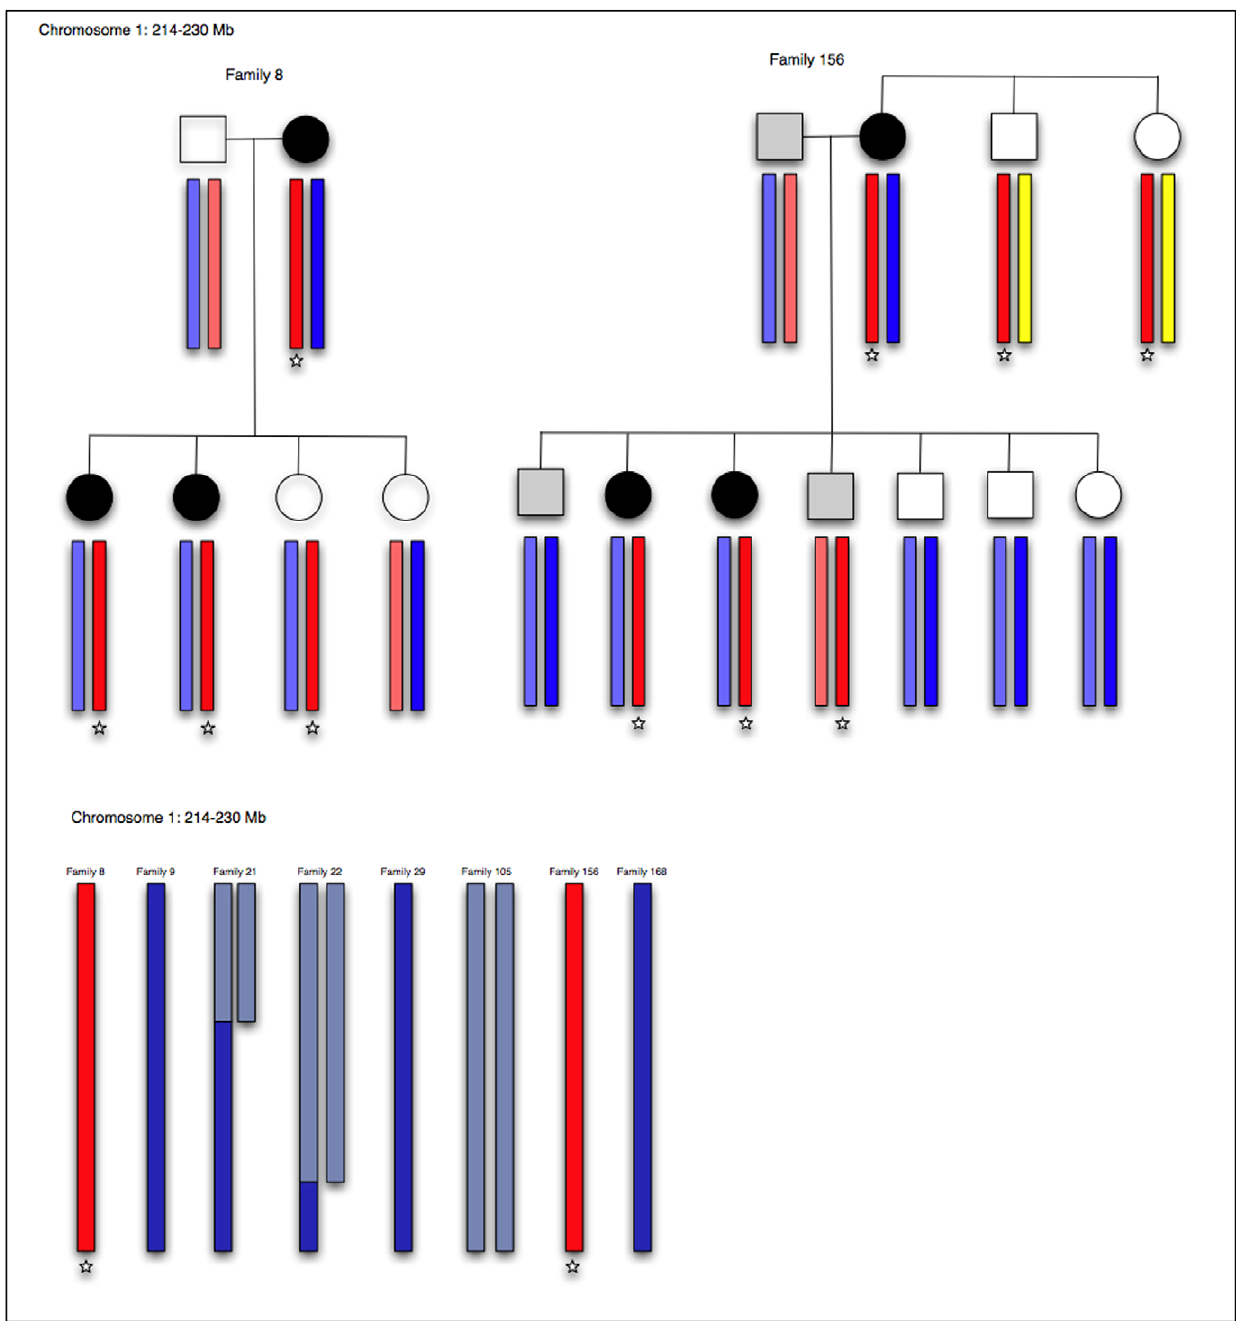
Figure 5. Segregating haplotypes and IBD allele sharing. Putative risk haplotypes (shown in red and designated with a star) are shown for two families where the parents in both families were genotyped and the phased haplotypes were resolved. Allele sharing identical by descent is shown for six additional families (five ASPs and one affected sibling trio). Phased haplotypes were not resolved in families where parental genotypes were missing. Regions with one allele shared IBD are shown in dark blue; regions with two alleles shared IBD are shown in purple.